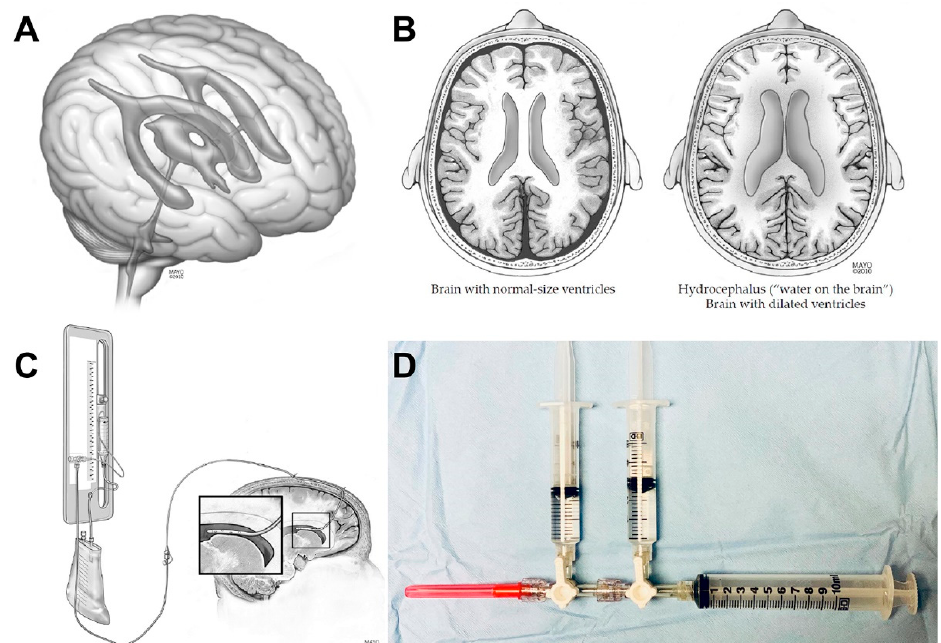
Figure 1. ( A , B ) Ventricular anatomy in aneurysmal subarachnoid hemorrhage. Hydrocephalus can occur from obstructive or nonobstructive (communicating) patterns, which benefit from external ventricular drain (EVD) placement, cerebral spinal fluid (CSF) diversion, and intracranial pressure monitoring. ( C ) EVD Becker drainage system, location of EVD catheter in the lateral ventricle, and location of typical intraventricular nicardipine injection. ( D ) Three-way stopcock EVD injection apparatus for sterile isovolemic drug injection. Red 18G needle (bottom left) for insertion into the EVD rubber port to inject/aspirate. Left syringe: Intraventricular nicardipine (drug) injection port. Middle syringe: Sterile preservative-free saline flush. Right syringe: Large 10 mL syringe used to aspirate CSF for isovolemic procedure, “Volume out must equal volume in”. Used with permission of Mayo Foundation for